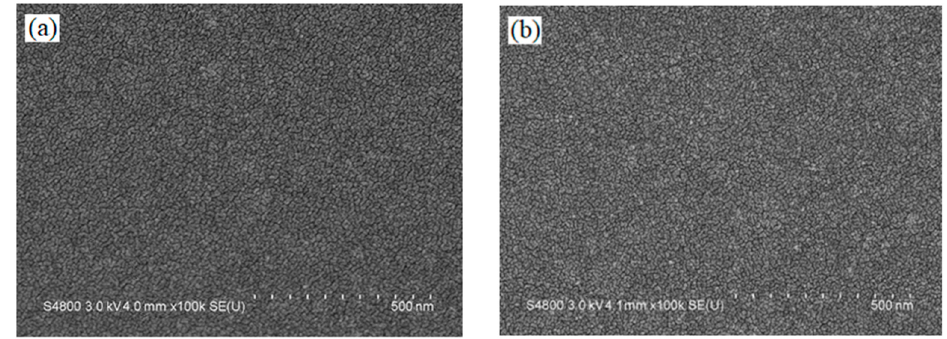
Figure 7. The top-view SEM image of ( a ) 20-layer; ( b ) 23-layer BPFs.